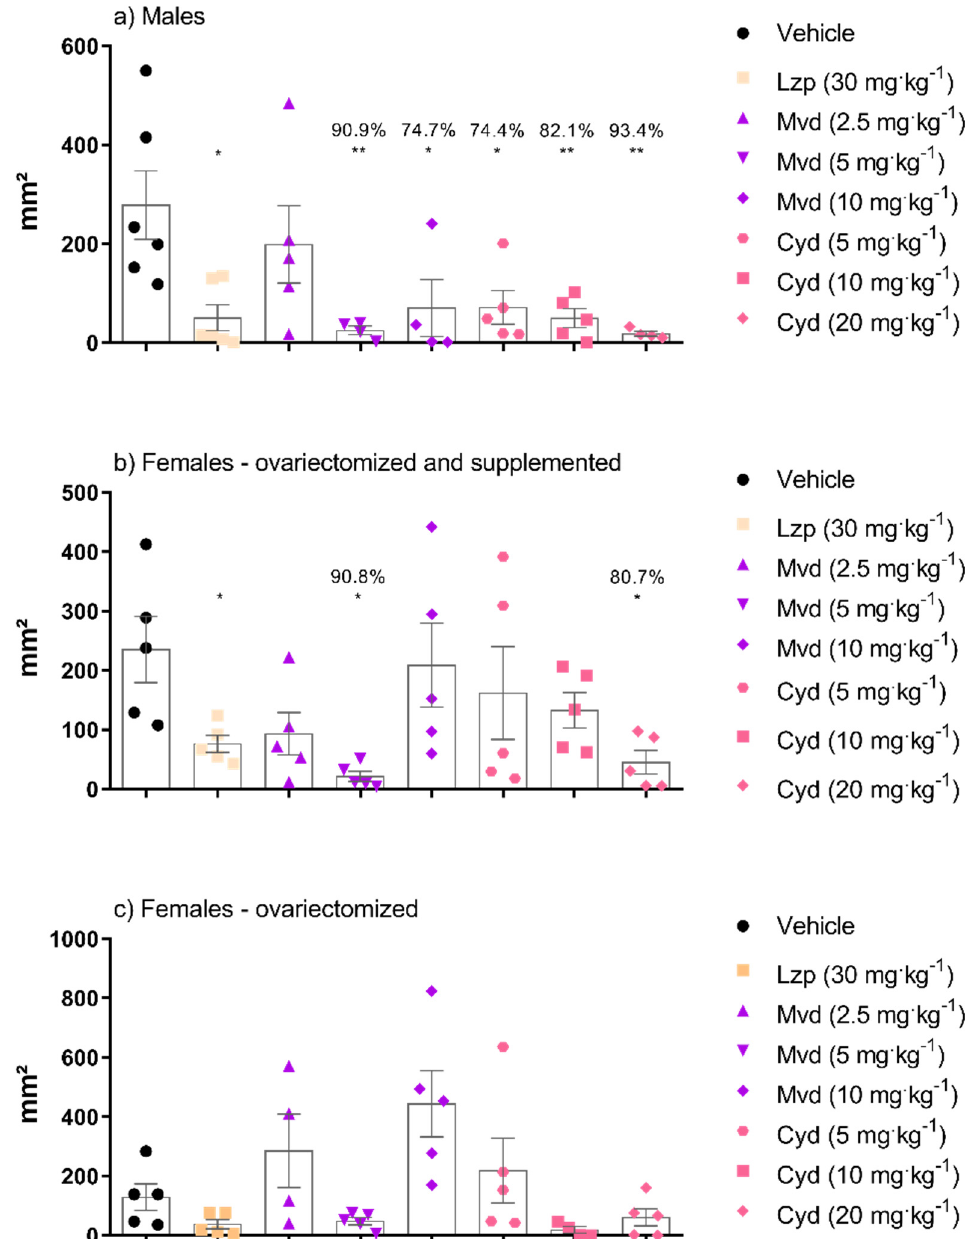
Figure 3. Effect of oral treatment with malvidin or cyanidin chloride in the prevention of gastric lesions induced by ethanol. The results indicate the mean lesion area for each treatment, in the different groups: ( a ) male animals, ( b ) female animals ovariectomized and supplemented with 17 β -estradiol (500 µ g/kg) and ( c ) group of ovariectomized female animals without supplementation. Data are presented as mean ± S.E.M. ANOVA followed by the Dunnett’s test; where * p < 0.05 and ** p < 0.01, compared to the respective vehicle group. Percentage numbers indicate inhibition of lesion formation.